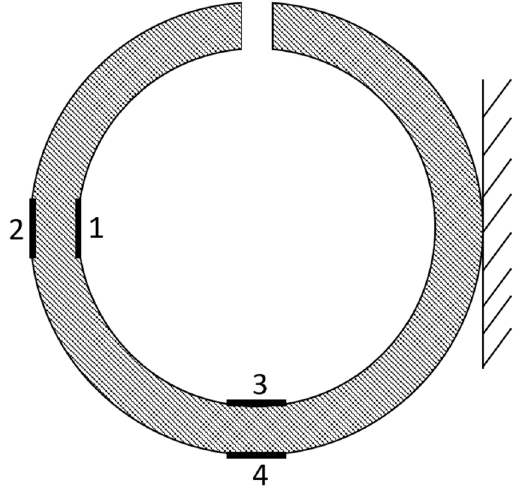
Figure 3. Diagram of the strain gauges’ locations in the slitting method.